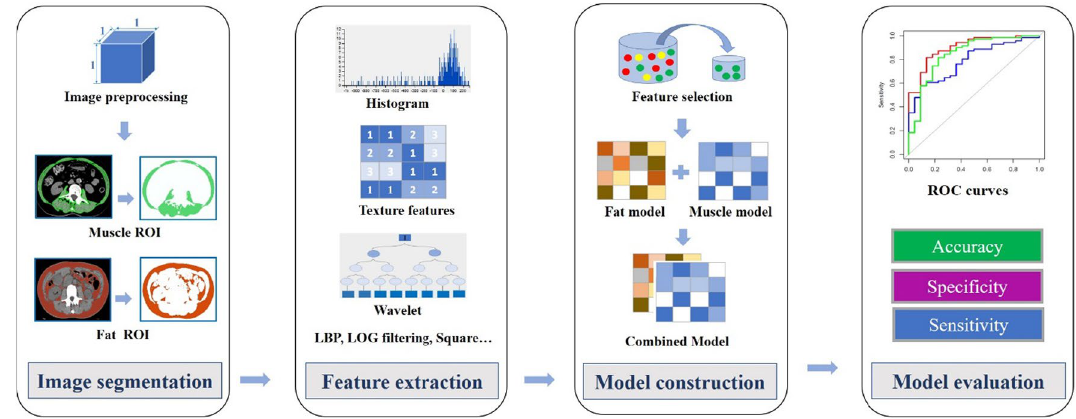
Fig. 2 Rdiomics workflow and study flowchart. ROI region of interest, ROC Receiver Operating